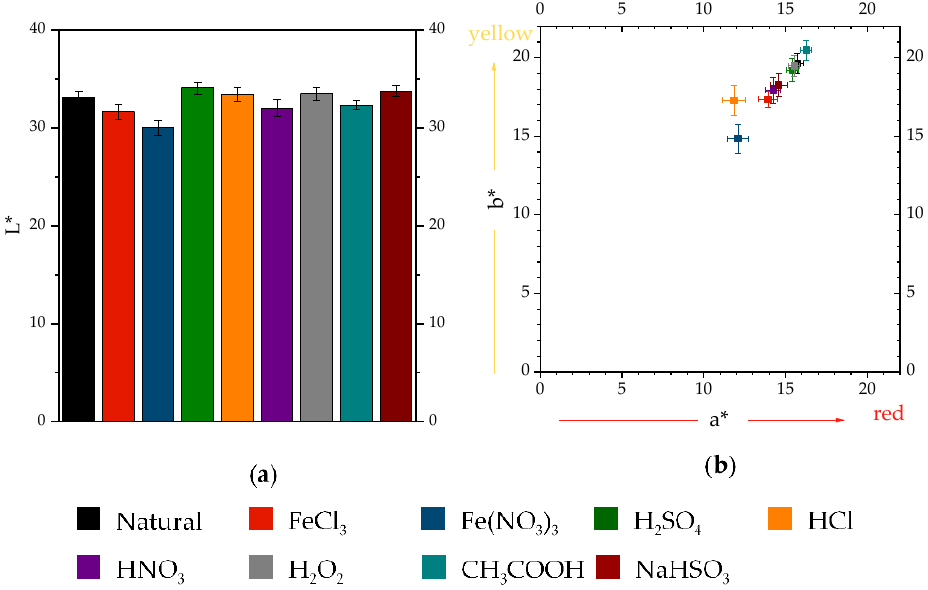
Figure 7. Lab values of the accelerated patinas after 24 months of exposure to the Madrid atmosphere: ( a ) L* value and ( b ) a* versus b* values.